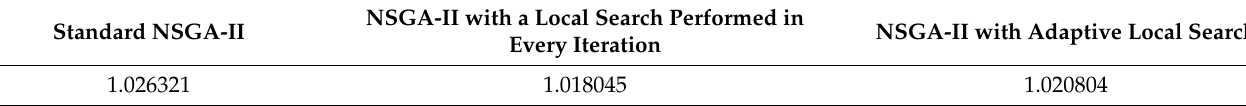
Table 12. Spacing metric.